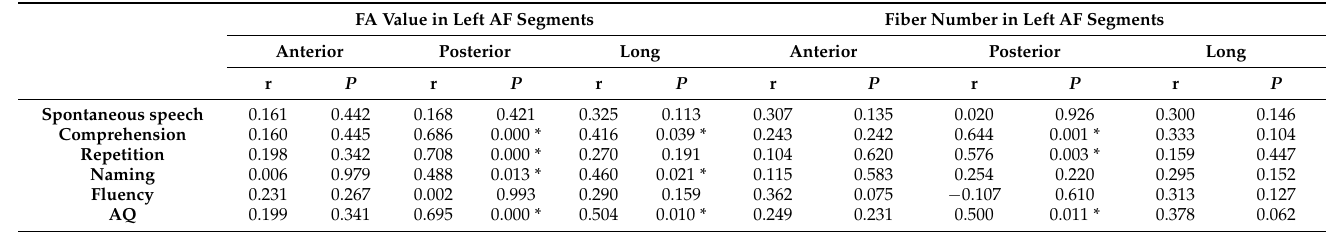
Table 3. The partial correlation analyses between language performance and diffusion indices (controlled variable: lesion